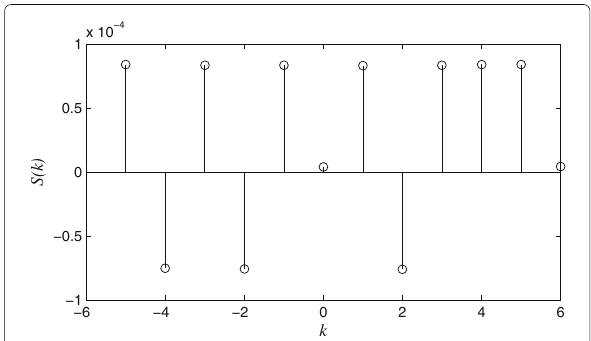
Fig. 5 D-BFT of 10-chirp-rate symbols { 1, − 1,1, − 1,1,1, − 1,1,1,1 } .